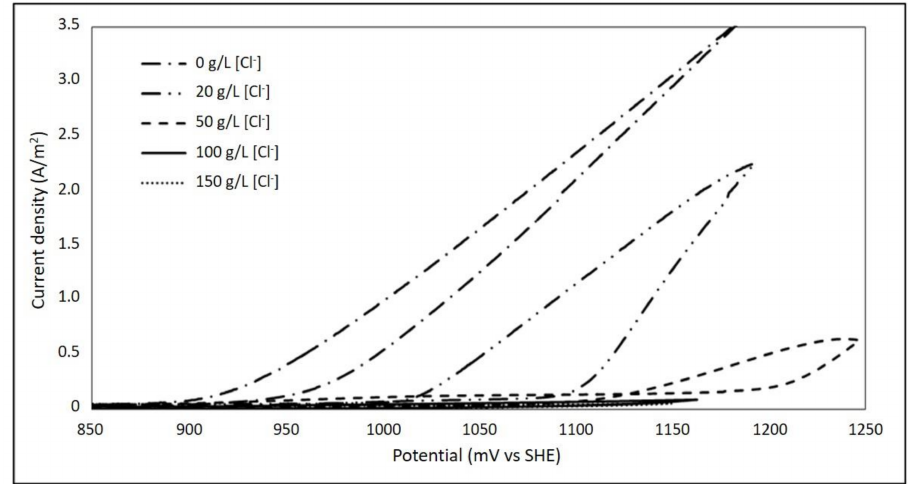
Figure 5. Effect of chloride ions in transpassivation zone (above 850 mV) on the chalcopyrite electrode (1 mV/s) at 0, 20, 50, 100, and 150 g/L [Cl − ] using a solution with 0.5 g/L [Cu 2+ ], 1.0 g/L [Fe 2+ ], and pH 1 adjusted with sulphuric acid at 25 ◦